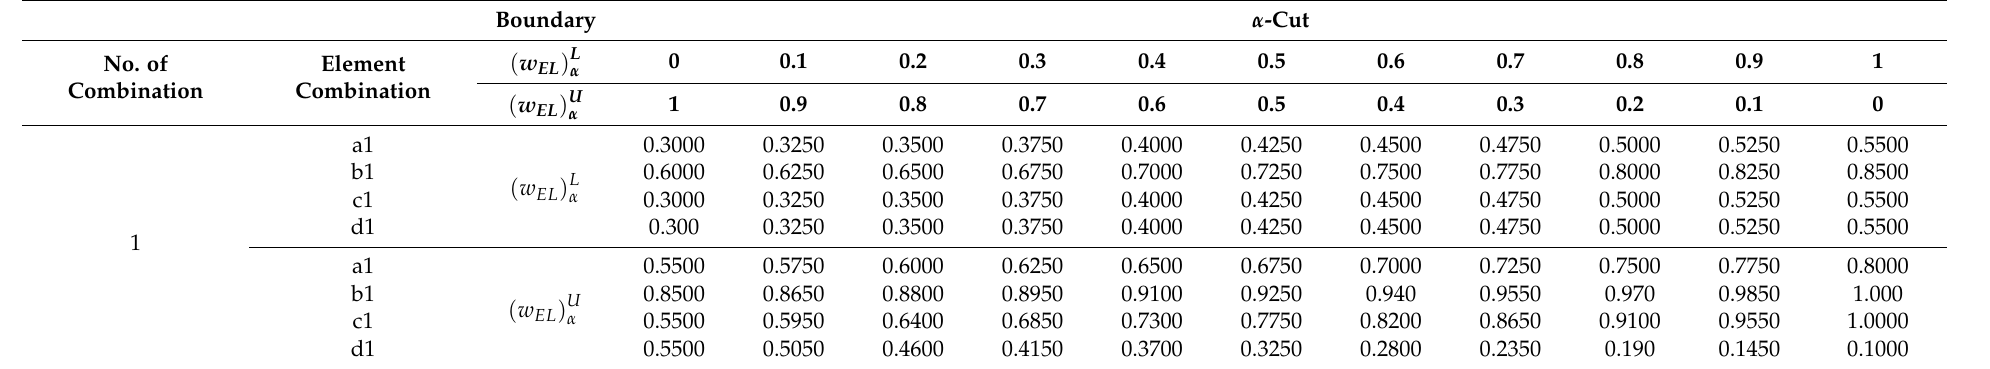
Table A3. The α -cut sets of elements fuzzy structural importance according to each combination (extended version of Table 7). Boundary α